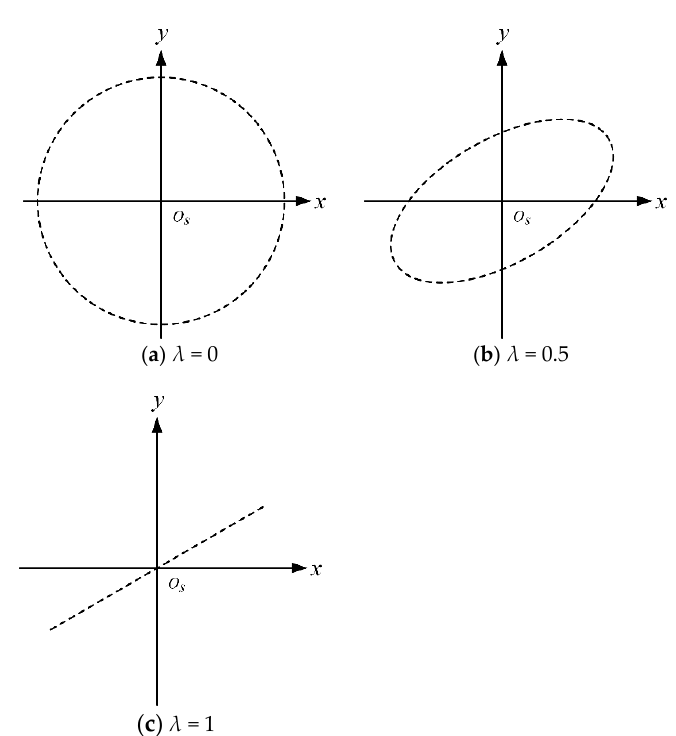
Figure 16. Three typical whirl orbits.